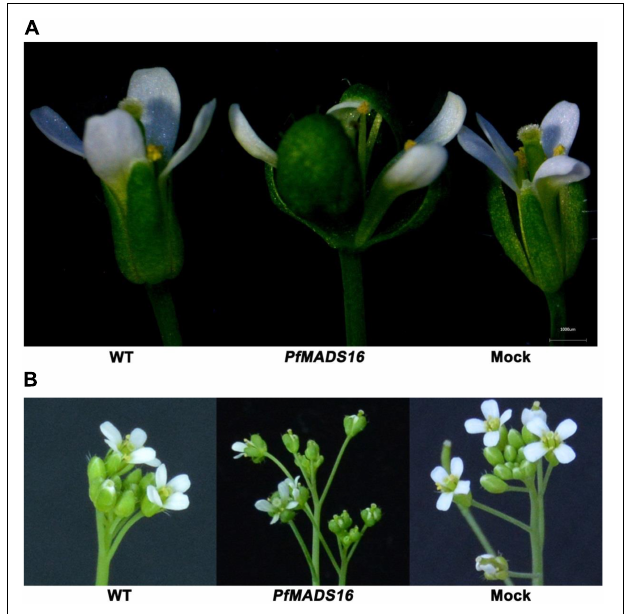
FIGURE 2 | Representative phenotype changes in flowers of PfMADS16 transgenic Arabidopsis plants in comparison to WT and Mock plants. (A) Morphological differences of a single flower. (B) Morphological differences of the inflorescence. Flower phenotype changers among transgenic lines are